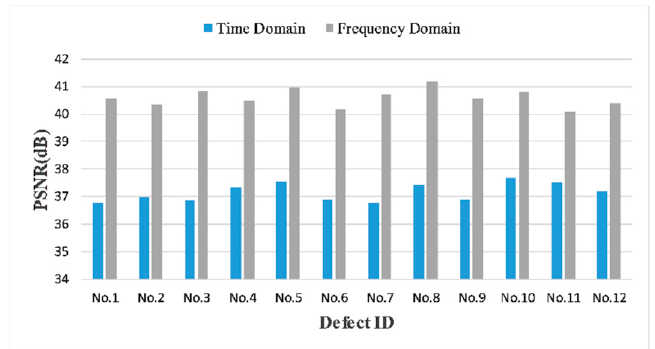
Figure 26. Comparative PSNRs between time and frequency domain for all pit defects, using 50 MHz SR, 60% CR in time domain and 20 MHz SR, 50% CR in frequency domain.